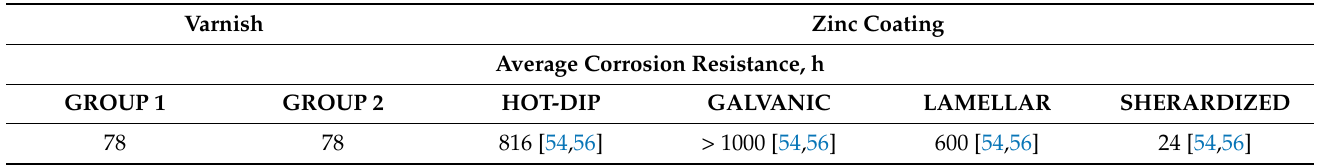
Table 5. Comparison of the varnish and zinc coatings average corrosion